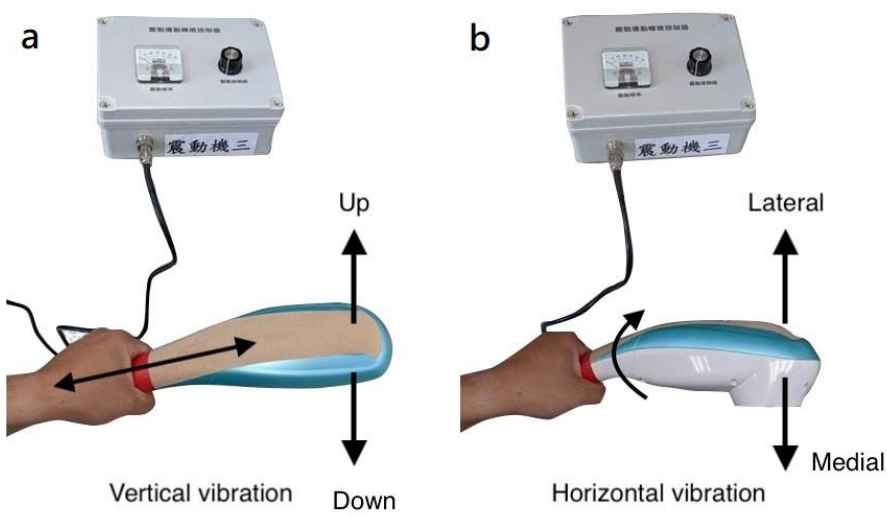
Figure 2. Illustrations for vertical ( a ) and horizontal ( b ) vibration conditions.